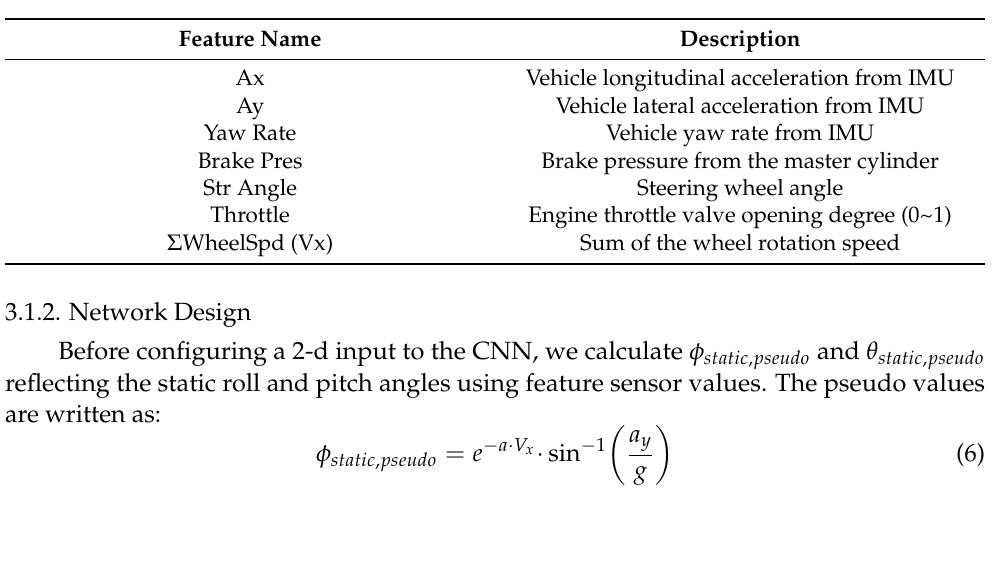
Table 2. Selected features considering sensor